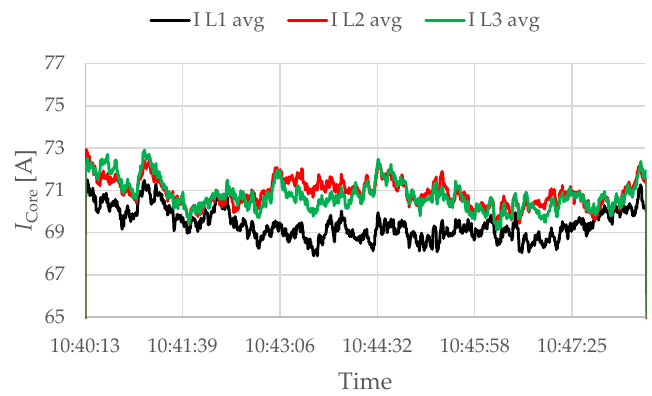
Figure 6. Cores currents measured in Substation 2. Actual operating system of sheaths (Sh1). Operation only with the analyzed line.